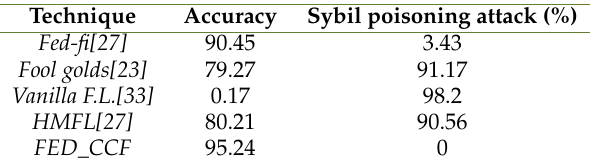
Table 3. Comparison with other algorithms